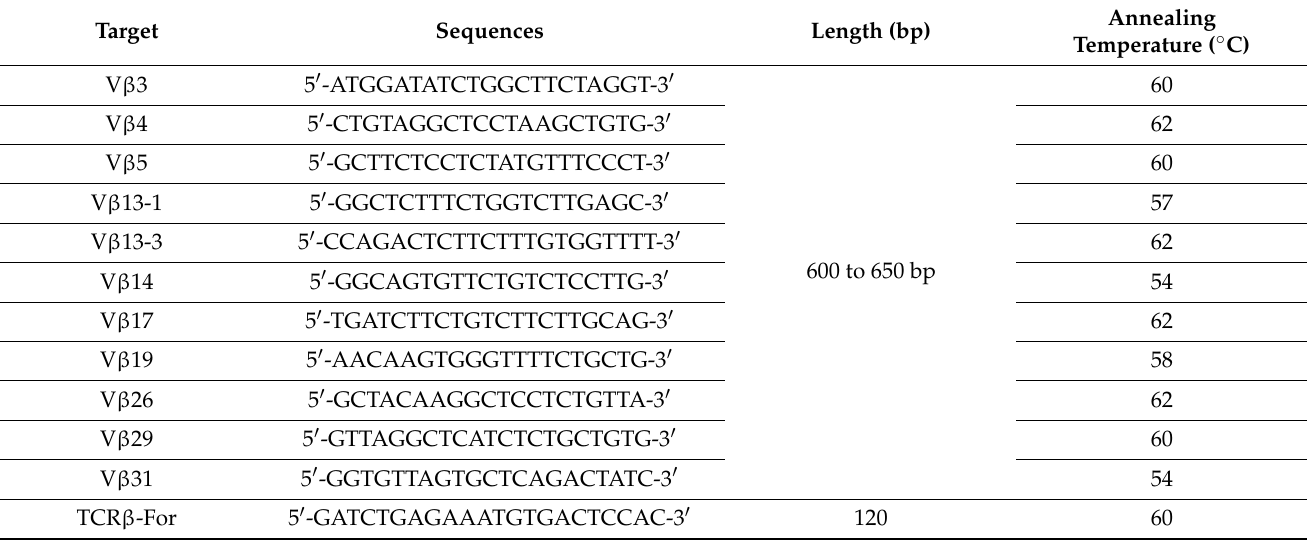
Table 4. Primers used to study V β usage in the TCR β